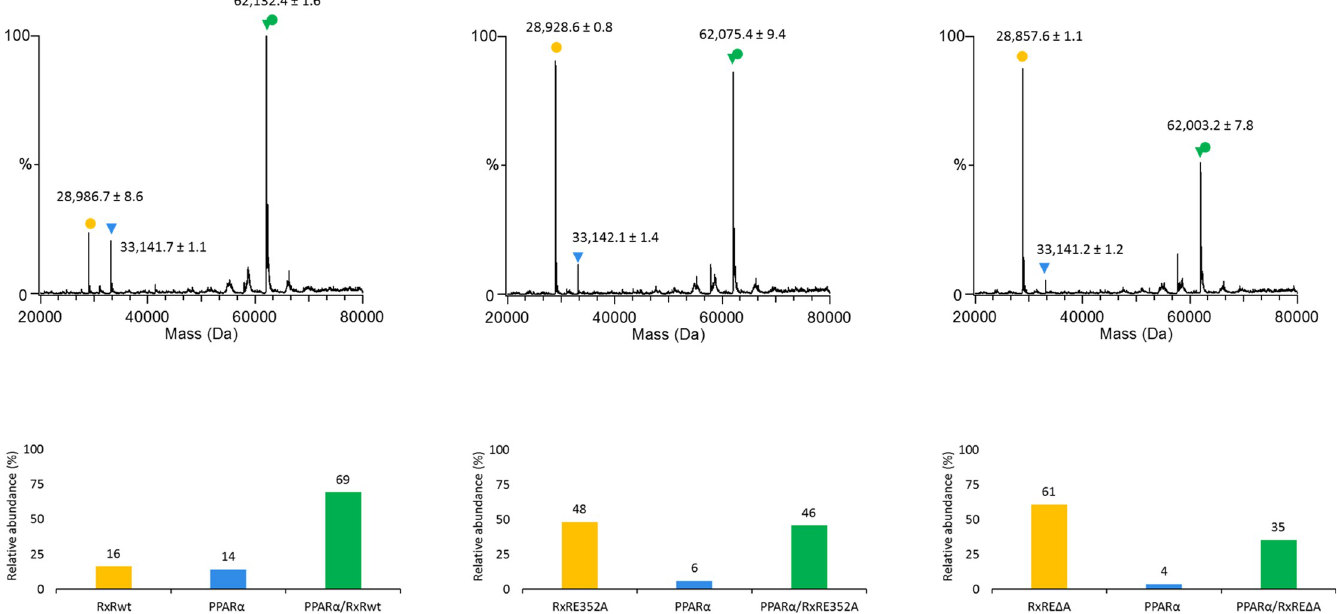
Fig 6. Heterodimerization capacity of wild-type (wt) RXR α LBD and mutant E352A and Δ E352 RXR LBD with PPARalpha. Size-exclusion chromatography (SEC)-coupled native mass spectrometry (MS) analysis for complex mixture of PPAR α LBD with either (A) wt RXR α LBD, (B) E352A RXR α LBD or (C) Δ E352 RXR α LBD. The isolated RXR α LBD (wt or mutants) is depicted in yellow, isolated PPAR α LBD in blue and heterodimeric PPAR α /RXR α LBDs in green. Mass spectra obtained by deconvolution of the raw data (shown in S6 Fig) for the three different complex mixtures are shown, together with the quantification of the species from the SEC-native MS analysis of the PPAR α /RXR α LBD complex mixture, shown below in the form of histograms.